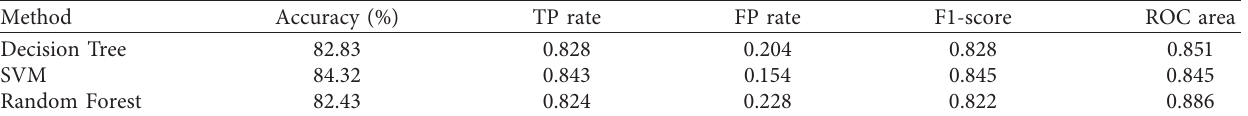
Figure 8: Contribution of individual features in the Deep Neural Network models. Table 1: Accuracy comparison in different machine learning